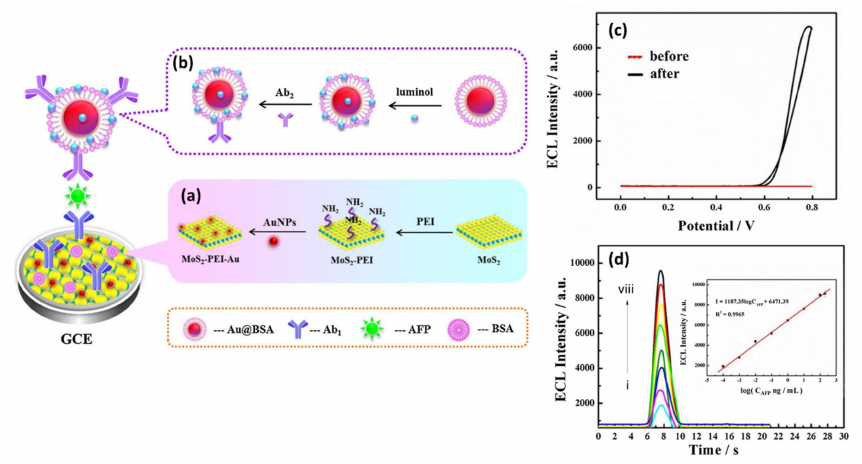
Figure 14. Schematic representation of the proposed immunosensor. ( a ) Formation of MoS 2 -PEI-Au nanocomposites and ( b ) the preparation procedure of the luminol-Au@BSA-Ab2 bioconjugation. ( c ) ECL profiles of the immunosensor before and after incubation with luminol-Au@BSA-Ab2 bioconju- gate in 0.01 M pH 7.4 PBS containing 3 mM H 2 O 2 and 10 ng/mL AFP. ( d ) ECL responses for AFP detection. The concentrations of AFP (ng/mL): (i) 0.0001, (ii) 0.001, (iii) 0.01, (iv) 0.1, (v) 1, (vi) 10, (vii) 100, and (viii) 200 (inset: calibration curve) [81]. Figures reproduced with permission from